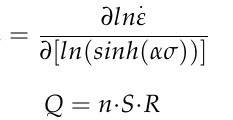
Figure 6. Fitting curve of n value.